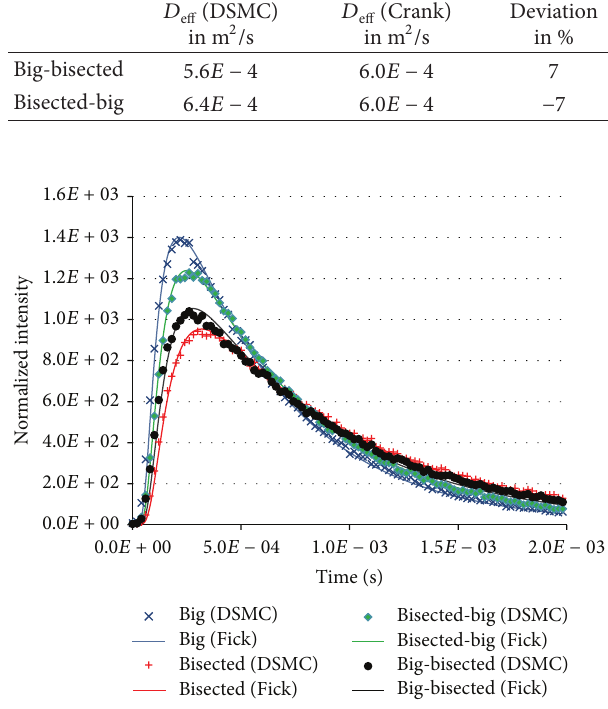
Figure 7: Pulse response of half-cylindrical shaped pore combina- tions and the individual pores.